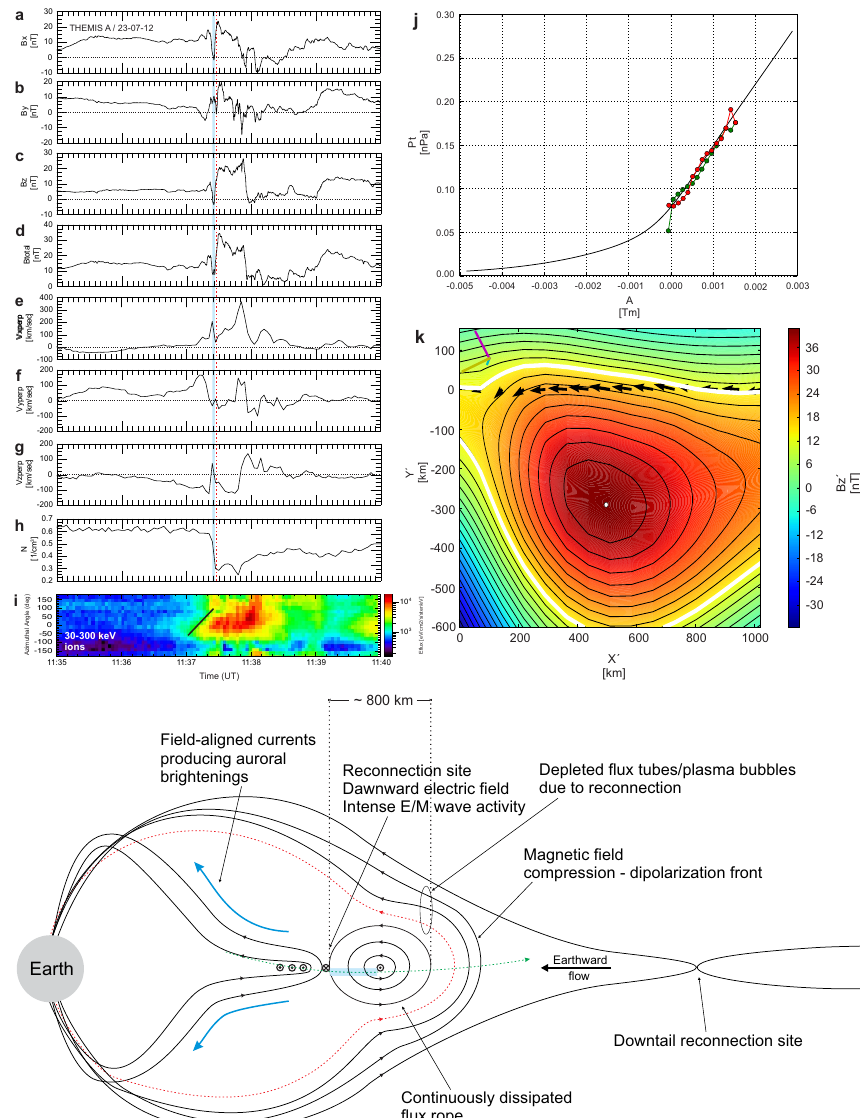
Figure 2. Near-Earth flux rope convected earthward observed by THEMIS A on 23 July 2012. Same format as in Fig. 1. The GS re- construction frame is projected onto GSM coordinates as follows: X (cid:48) = [− 0 . 044 , − 0 . 458 , − 0 . 888 ] , Y (cid:48) = [− 0 . 180 , 0 . 878 , − 0 . 444 ] , Z (cid:48) = [ 0 . 983 , 0 . 140 , − 0 . 121 ] . Panel (i) presents ion differential energy fluxes versus azimuthal angle in the probe rotation plane, measured by the solid-state telescope (SST) instrument in the 30–300keV energy range. Zero degrees correspond to earthward fluxes. The schematic illus- tration at the bottom of the figure is a qualitative representation of the substorm model we propose. The illustration is formed by a 2-D cut in a plane containing the Earth and the apex of the flux rope, where the invariant axis is approximately perpendicular to this plane (and not necessarily where the spacecraft crossed the flux rope). In this regard, the earthward flow label denotes the velocity of the HT frame estimated in the apex of the flux